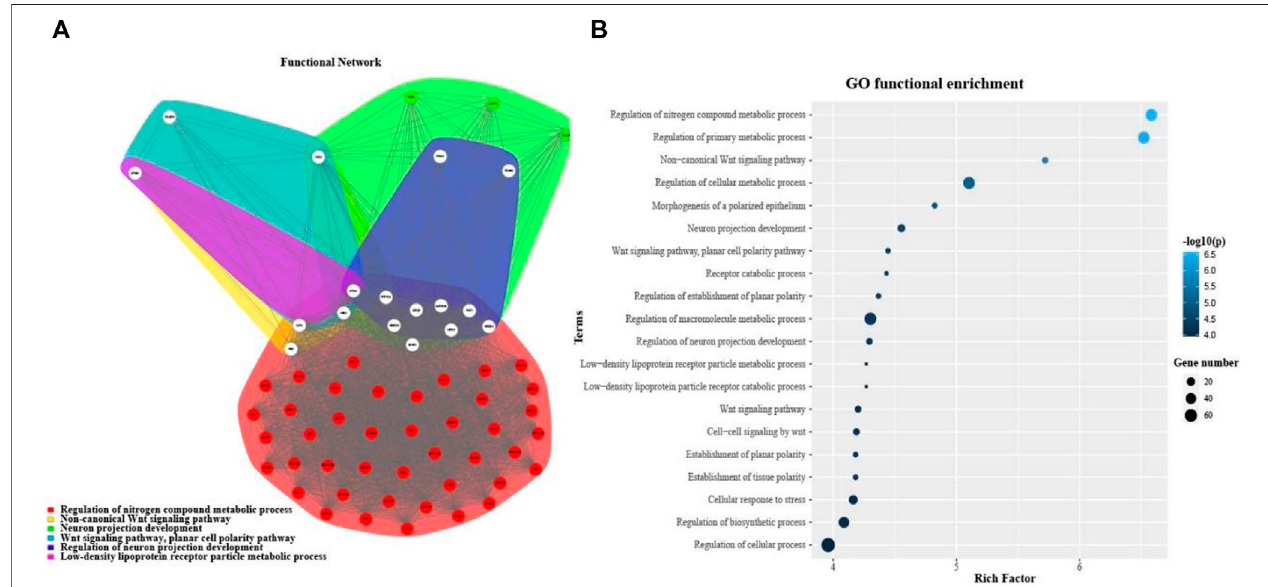
FIGURE 4 | Functional annotation of DMEDSig-4. (A) Functional Gene Network (FGN) of clusters de fi ned by topGO for DMEDSig-4 Targeted Genes. Edges: link genes annotated under the same enrichment terms. Node colors: functional clusters containing genes. White nodes: hub genes expressed in multiple clusters. (B) Bubble chart of function enrichment results of